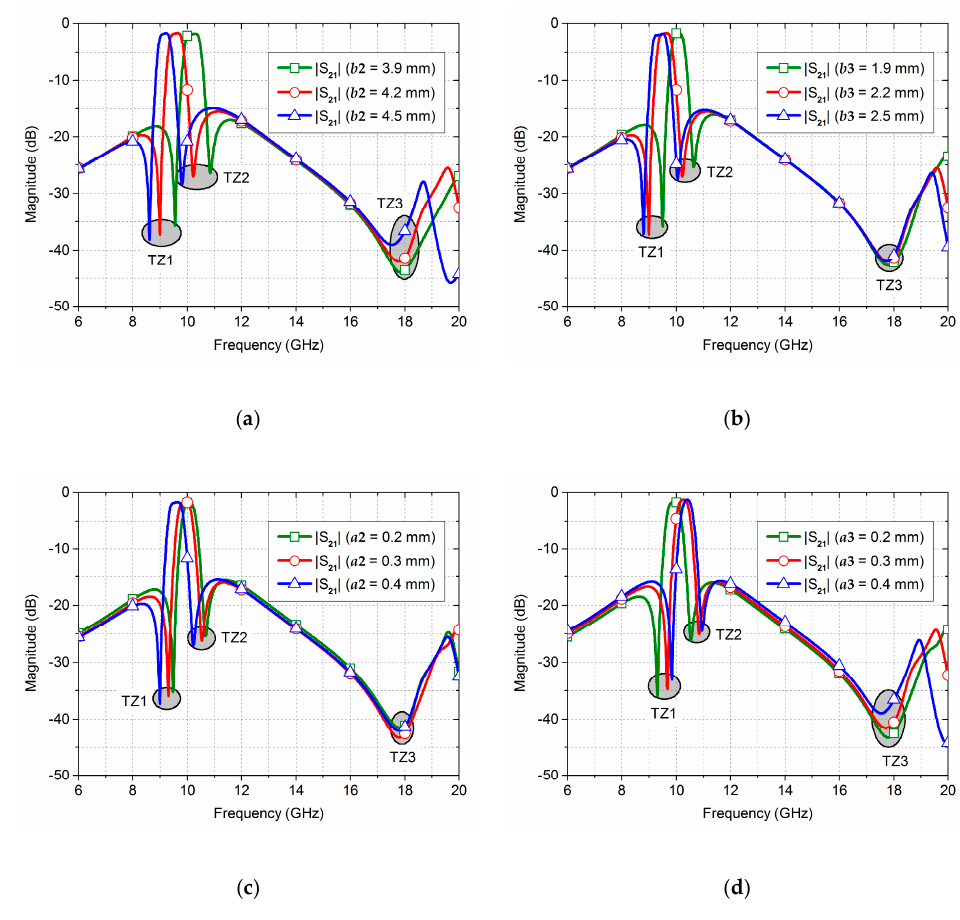
Figure 6. Simulated |S21| of the proposed single-ended bandpass filter with the variation of some geometrical parameters: ( a ) b 2; ( b ) b 3; ( c ) a 2; ( d ) a geometrical parameters: ( a ) b 2 ; ( b ) b 3 ; ( c ) a 2 ; ( d ) a 3.